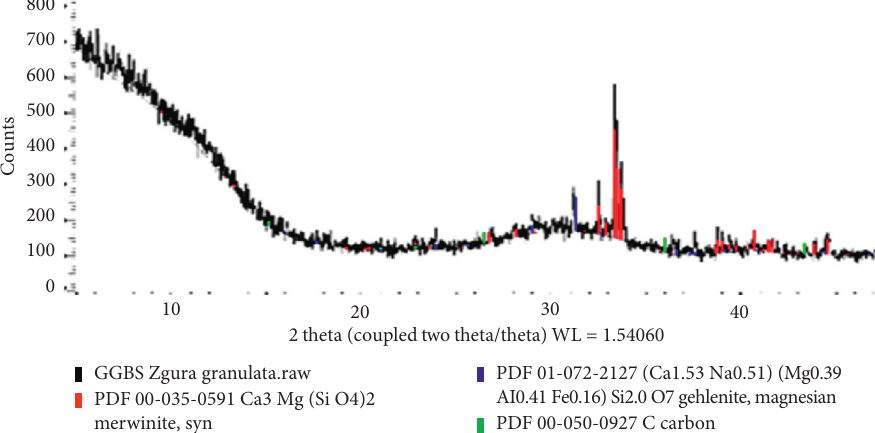
Figure 1: X-ray diffraction spectrum for GGBS with characteristic lines for magnesian gehlenite, merwinite, and